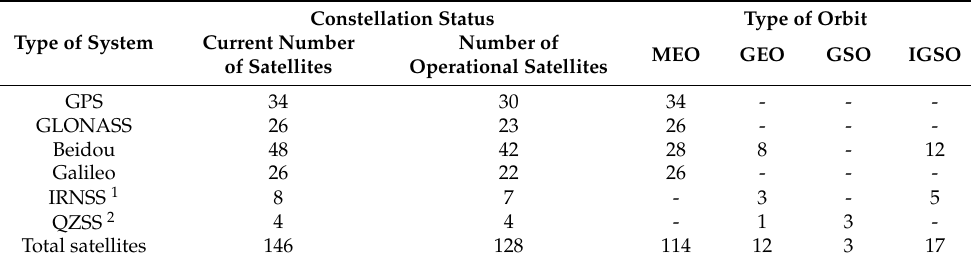
Table 1. The current status of the autonomous navigation system constellation. Constellation Status Type of Orbit Type of System Current Number Number of of Satellites Operational